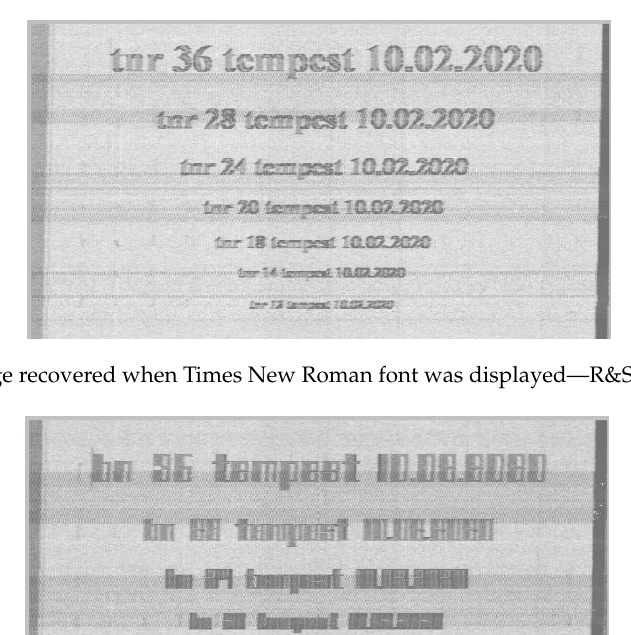
Figure 6. Image recovered when Arial font was displayed—R&S FSET receiver.